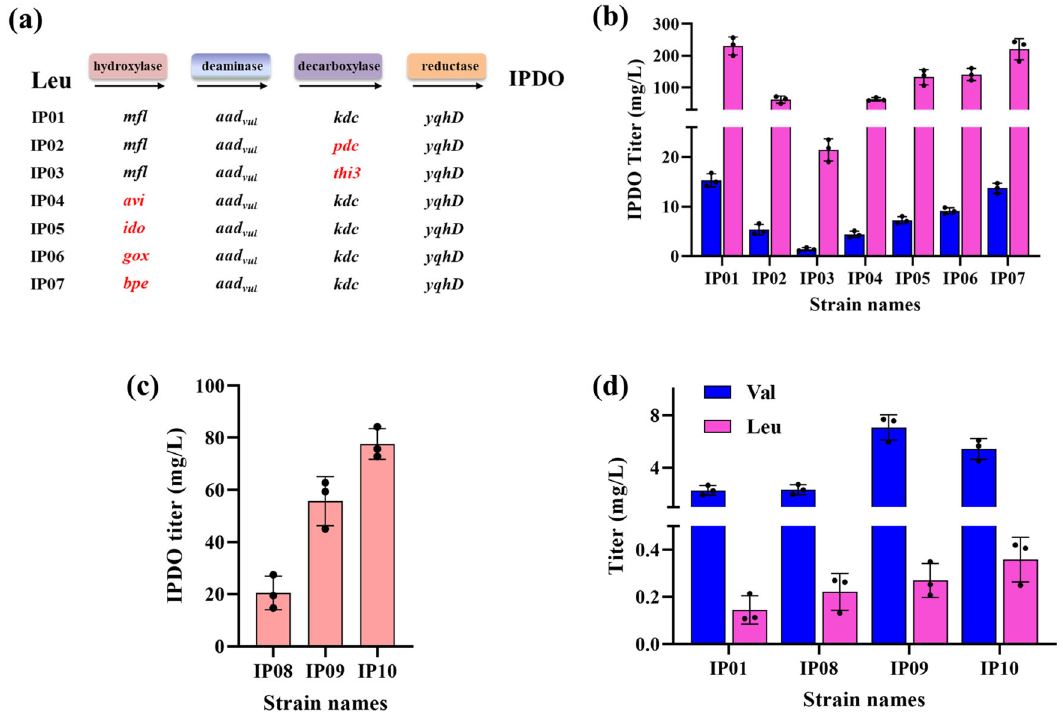
Fig. 5 Optimization of the biosynthetic pathway to improve IPDO production in E. coli . a IPDO production strain construction by screening hydroxylases and α -keto decarboxylase in the designed pathway from leucine to IPDO. b IPDO production of the constructed strains cultivated in the FM-II medium with (pink) and without (blue) the addition of leucine. c Increase IPDO production by the construction of strain IP08 overexpressing leucine operon ( leuA fbr BCD to enhance leucine supply and further strain IP09 overexpressing acetolactate synthase alsS and ilvCD to enhance 2-ketoisocapraote (KIC) supply. d Reducing the formation of the byproduct valine by constructing strain IP10 overexpressing tyrosine aminotransferase tyrB . IPDO and amino-acid titers were measured after 48 h of cultivation. Genes ilvIH , ilvCD, and leuABCD are from E. coli . Gene alsS are from Bacillus subtilis . For b – d , the average and s.d. of three biologically independent experiments are shown. Source data are provided as a Source Data fi